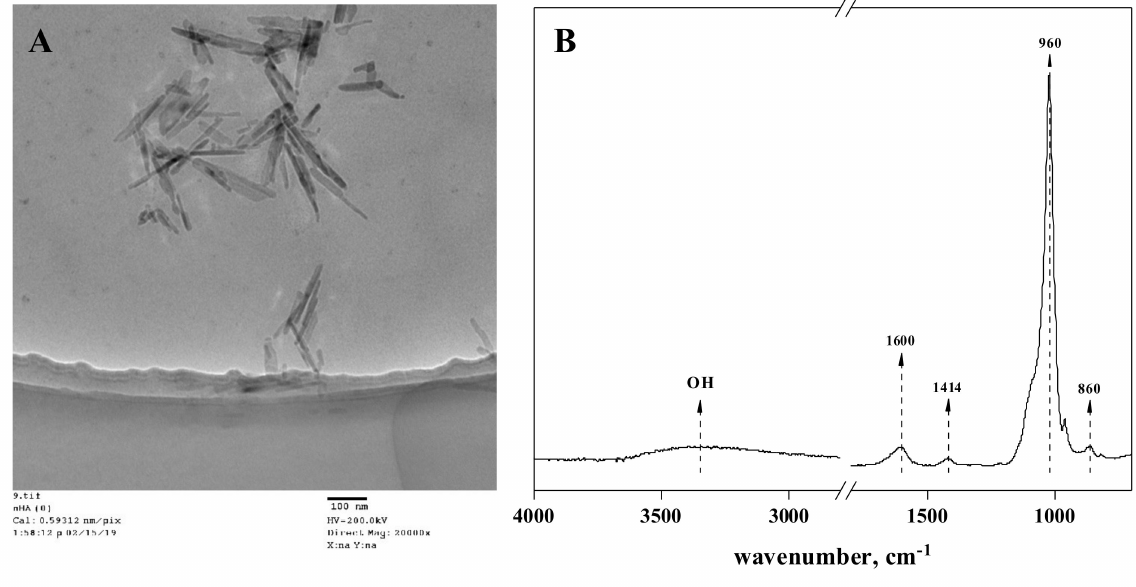
Figure 2. Characterization of the synthesized nHA: ( A ) TEM image (scale bar 100 nm), and ( B ) FTIR spectrum.